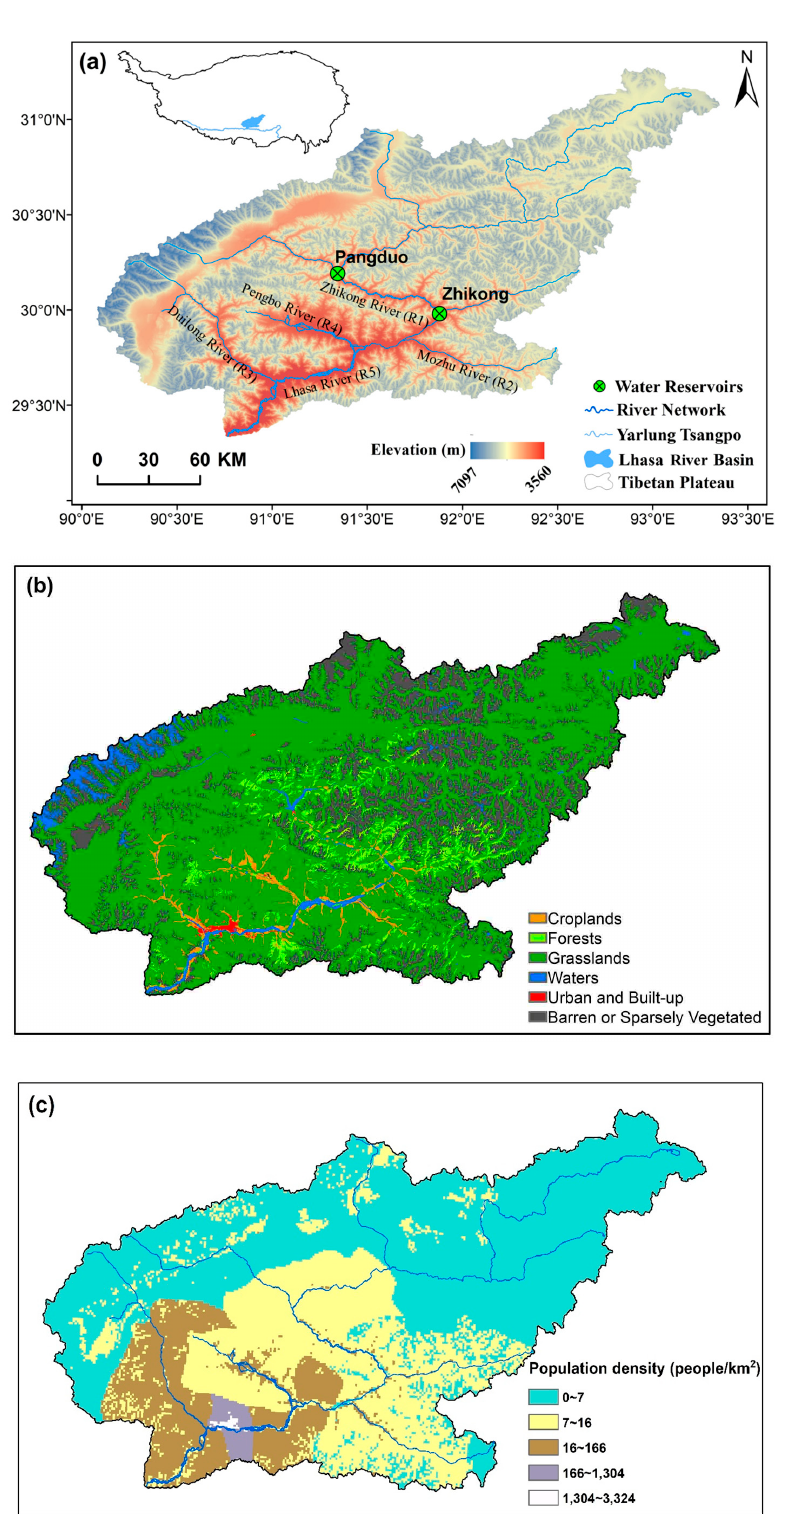
Figure 1. The study area: ( a ) location of the Lhasa River Basin; ( b ) the land cover map; and ( c ) spatial distribution of people density in 2015.